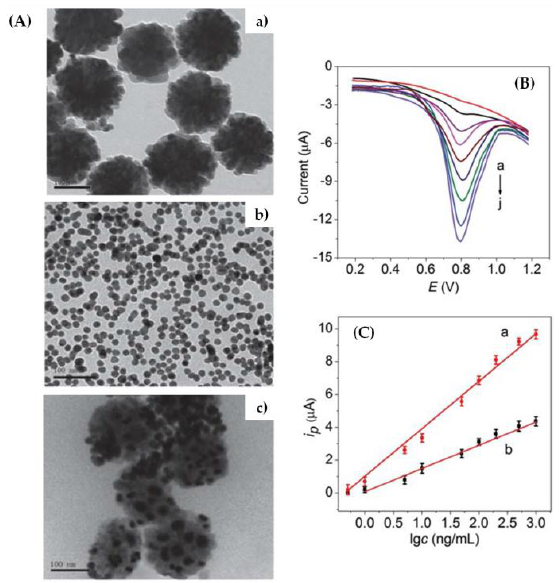
Figure 1. ( A ) TEM images of ( a ) Fe 3 O 4 , ( b ) gold nanoparticles, and ( c ) Fe 3 O 4 @gold nanocomposites; ( B ) square wave voltammetry measurements of methyl parathion with different concentrations between ( a ) 0.5 and ( j ) 1000 ng mL −1 ; and ( C ) calibration curves obtained with ( a ) and without ( b ) gold nanoparticles (Reproduced from Zhao et al. [8] with permission of The Royal Society of Chemistry).